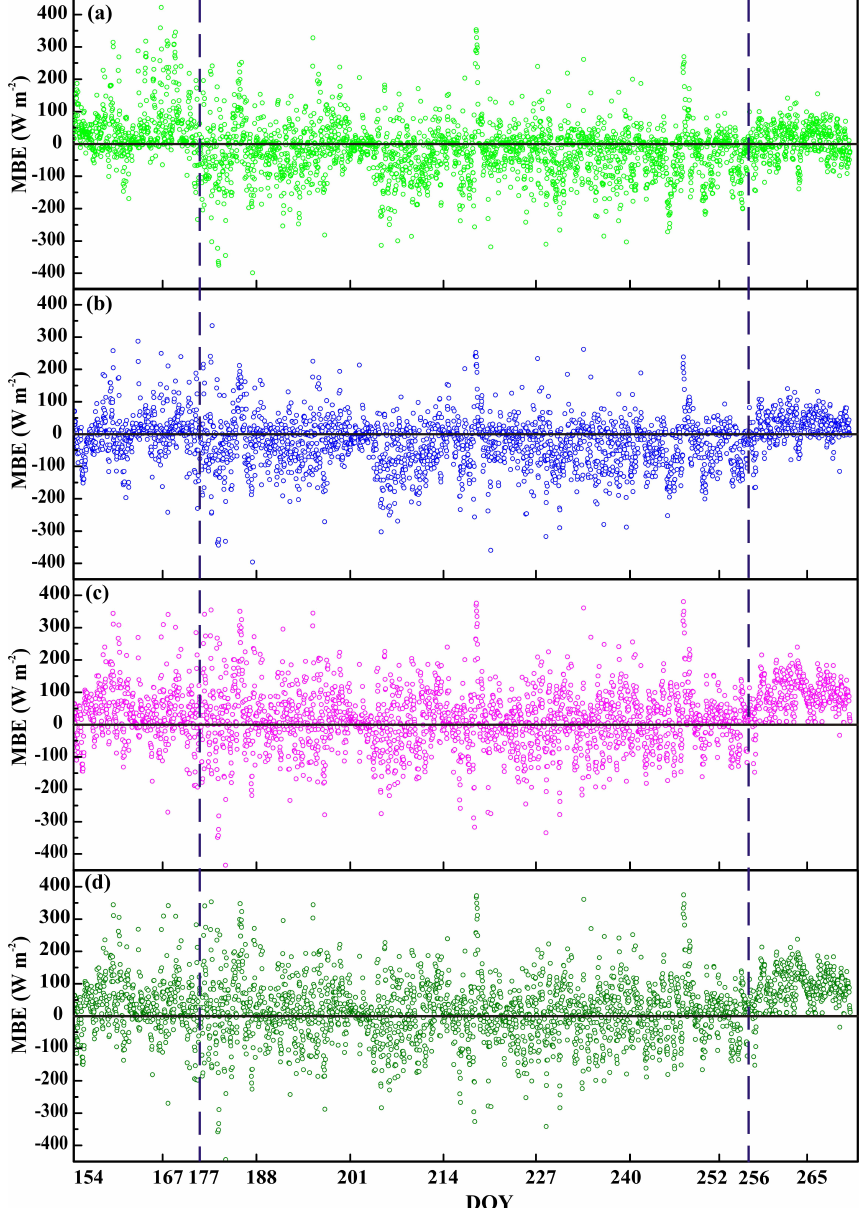
Figure 4. Mean bias error (MBE) of predicted and observed ET values for (a) PM, (b) SW, (c) PT–FC, and (d) AA models from DOY 154 to DOY 270. Parameters used for prediction are estimated by DREAM with the dataset for the calibration period from DOY 154 to DOY